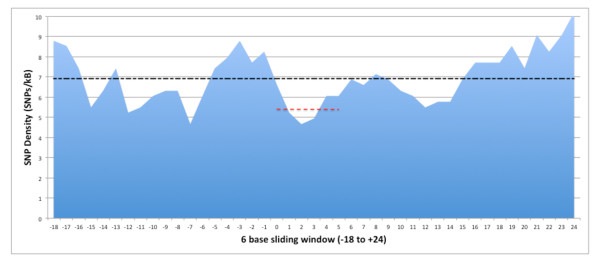
A measure of SNP density (SNPs/kb) generated from the analysis of a 6 base window sliding over a 42-base region - centered on the first position of the seed site - of 606 validated MREs. The black line indicates the number of SNPs/kB across the 42 base region. The red line indicates the average SNP density across the 6 windows of seed positions 2-7.